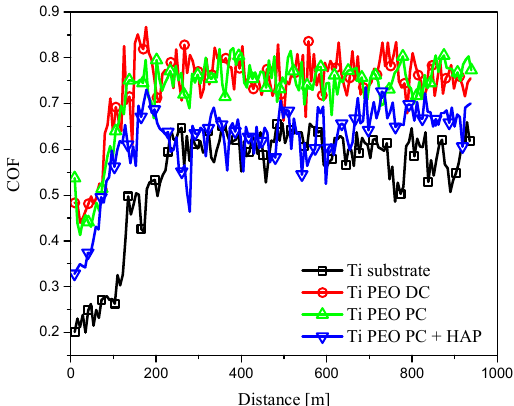
Figure 10. COF evolution for Ti-based samples vs. 100Cr6, F = 5 N, 300 rot/min.